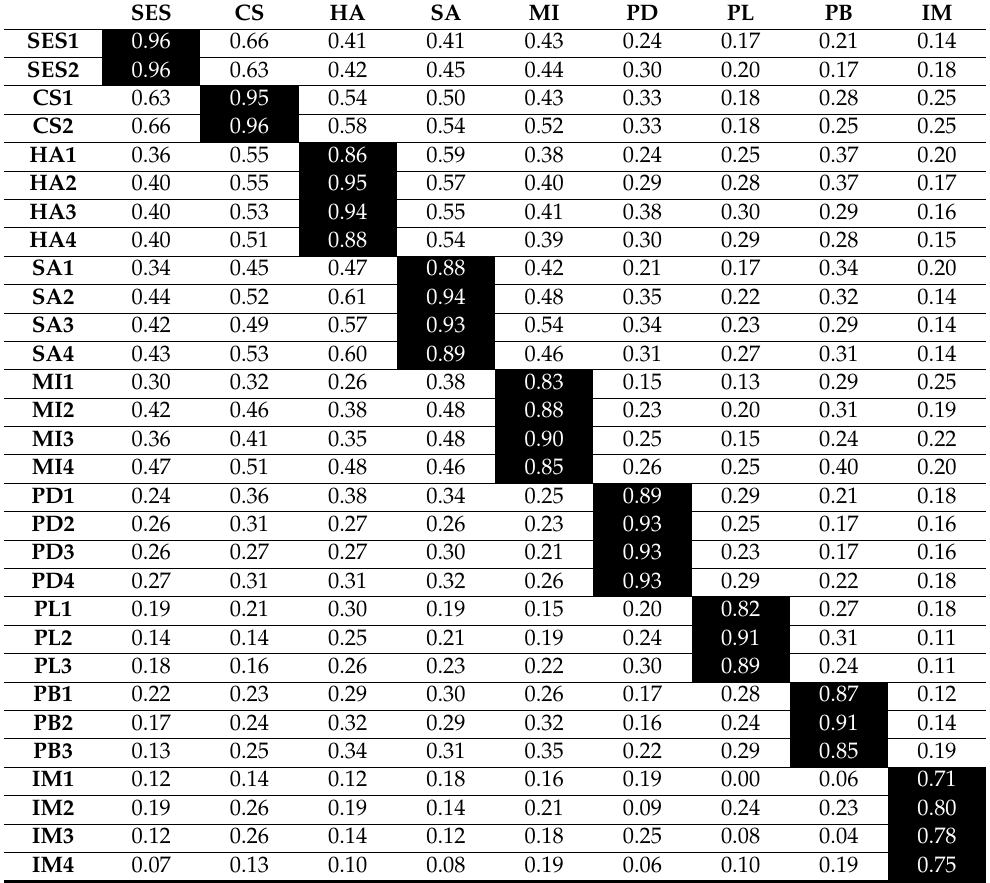
Table 6. Loadings and cross-loadings.